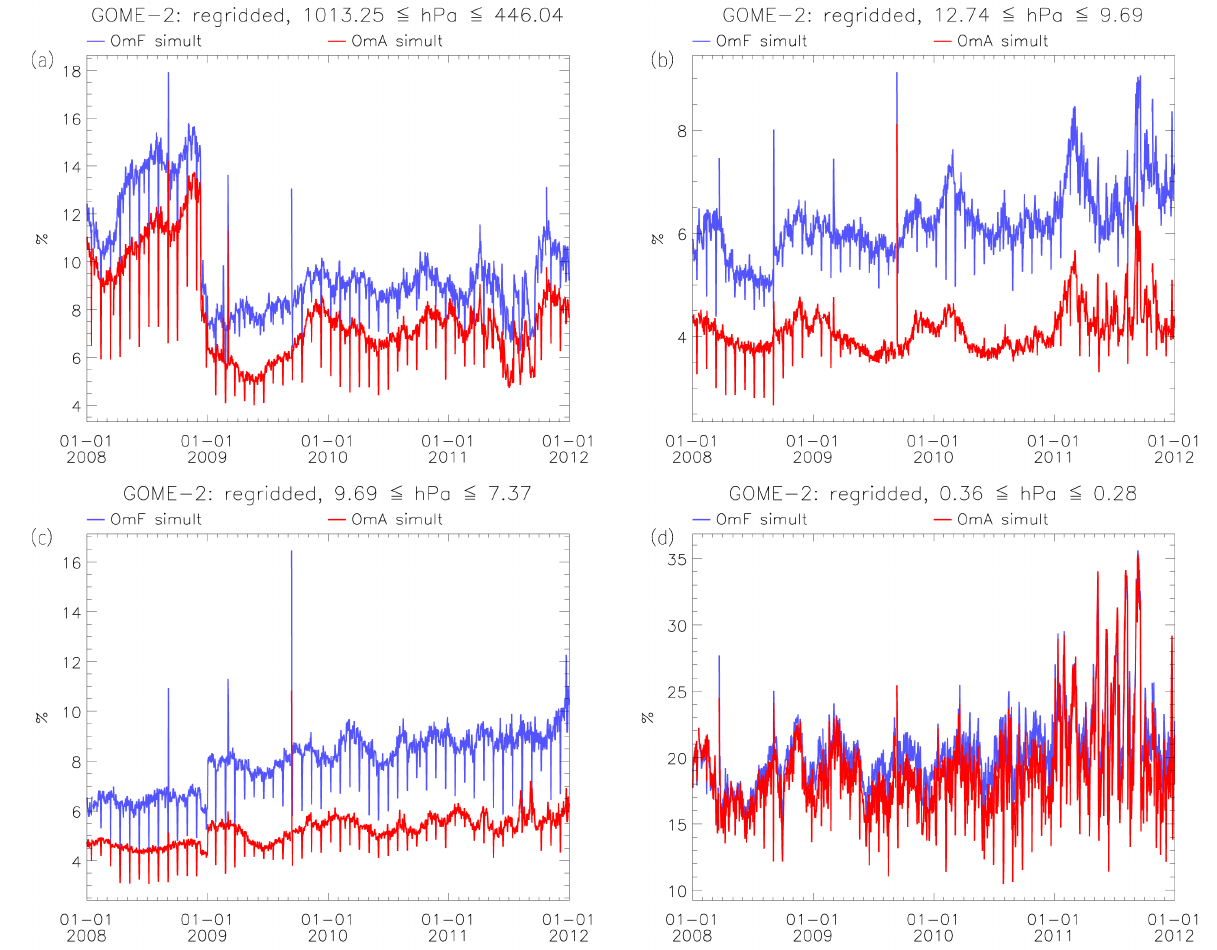
Figure 7. GOME-2 OmF (blue) and OmA (red) for the surface layer (a) , around 10hPa ( b and c ) and around 0.3hPa (d) . The OmF and OmA have been calculated for the regridded layers from the model run with simultaneous assimilation of GOME-2 and